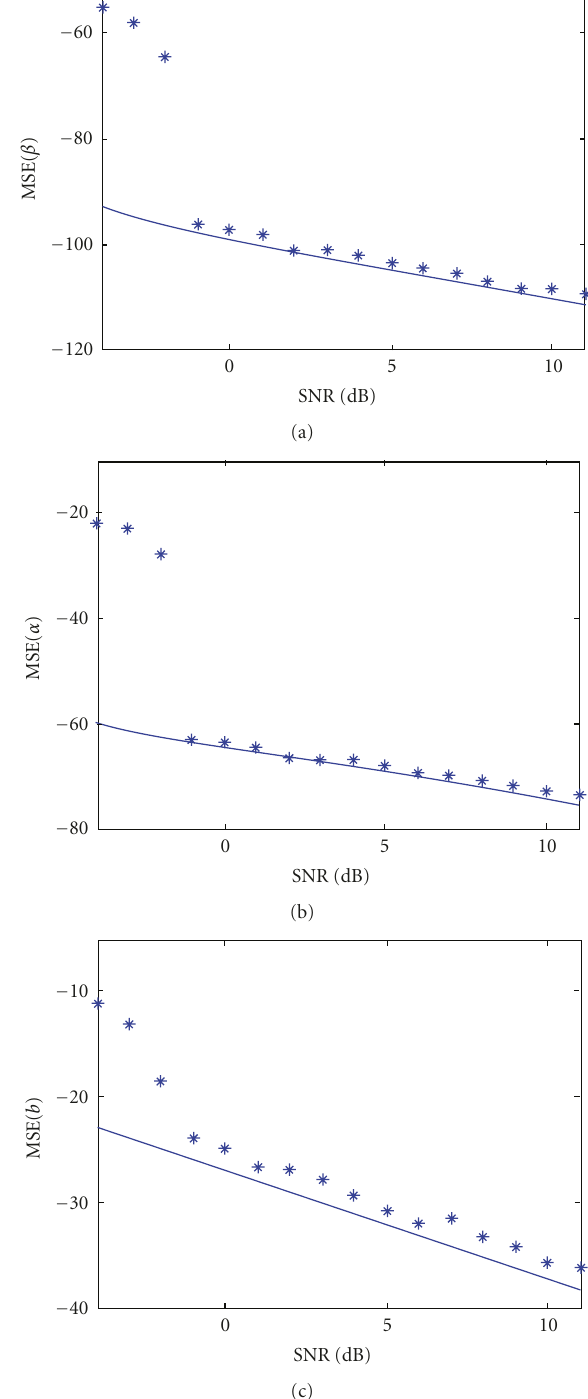
Figure 3: MSEs of parameter estimates of the first component. (Full lines are the theoretical MSEs, and circles indicate measured